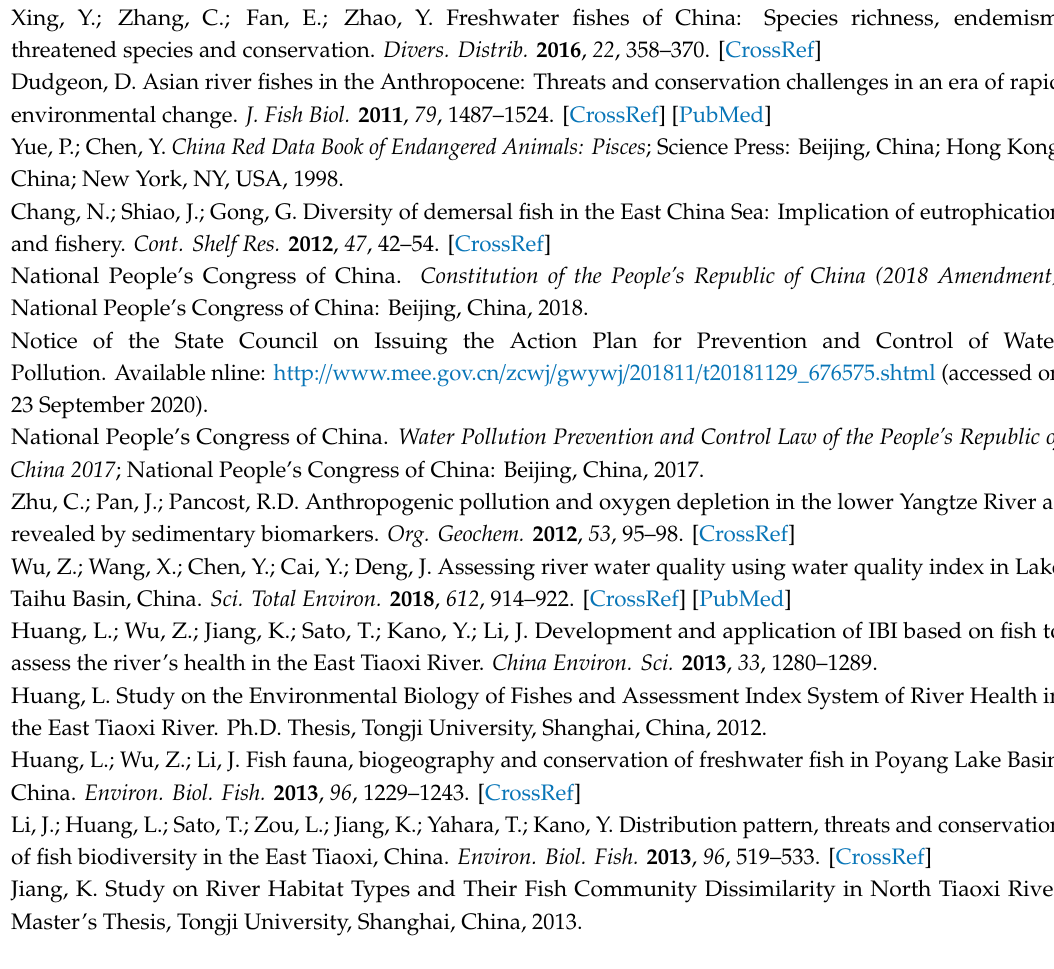
Figure S1: Fish species composition in the East Tiaoxi River [13], Figure S2: Fish species richness in each stream order of the East Tiaoxi River [13], Figure S3: The relation between Leptobotia tchangi ’s density and stream velocity at di ff erent sampling sites [11], Figure S4: The relation between Leptobotia tchangi ’s body size and pebble size at di ff erent sampling sites [11], Figure S5: Canonical Correspondence Analysis (CCA) of environmental factors and fish assemblage [11], Figure S6: Impacts of anthropogenic activities to non-parametric multidimensional scaling (NMDS) ordination of fish assemblages [11], Table S1: The list of fish species and their distribution in the East Tiaoxi River [13], Table S2: Criteria for river health assessment based on ecological integrity of fish in the East Tiaoxi River [11], Table S3: River health condition based on Fish Integrated Biotic Index [11], Table S4: Matrix of Spearman r s correlation coe ffi cients of environmental variables [11], Table S5: One-way ANOSIM for analysing the impacts of human activities on fish communities